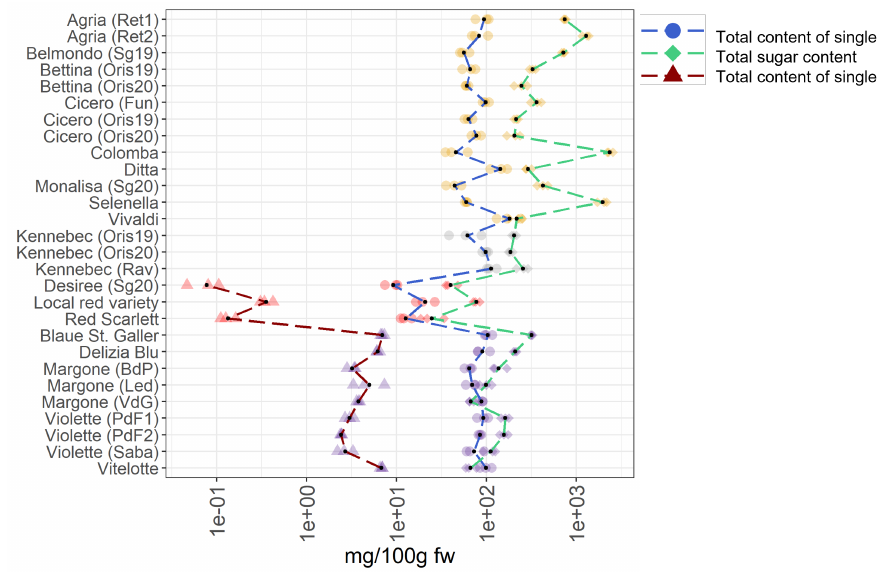
Figure 7. Total content of single polyphenols, total content of sugars, and total content of single anthocyanins in 28 potato varieties organized in four groups (yellow-, white-fleshed, red-skinned, and purple-fleshed); three biological replicates for each sample were analyzed. The black points represented the averages calculated on three biological replicates. The long dash lines showed the concentration trends amongst the potato groups. The concentrations were transformed in a log-10-scale. fw = fresh weight. For more detailed information about potato varieties see Table